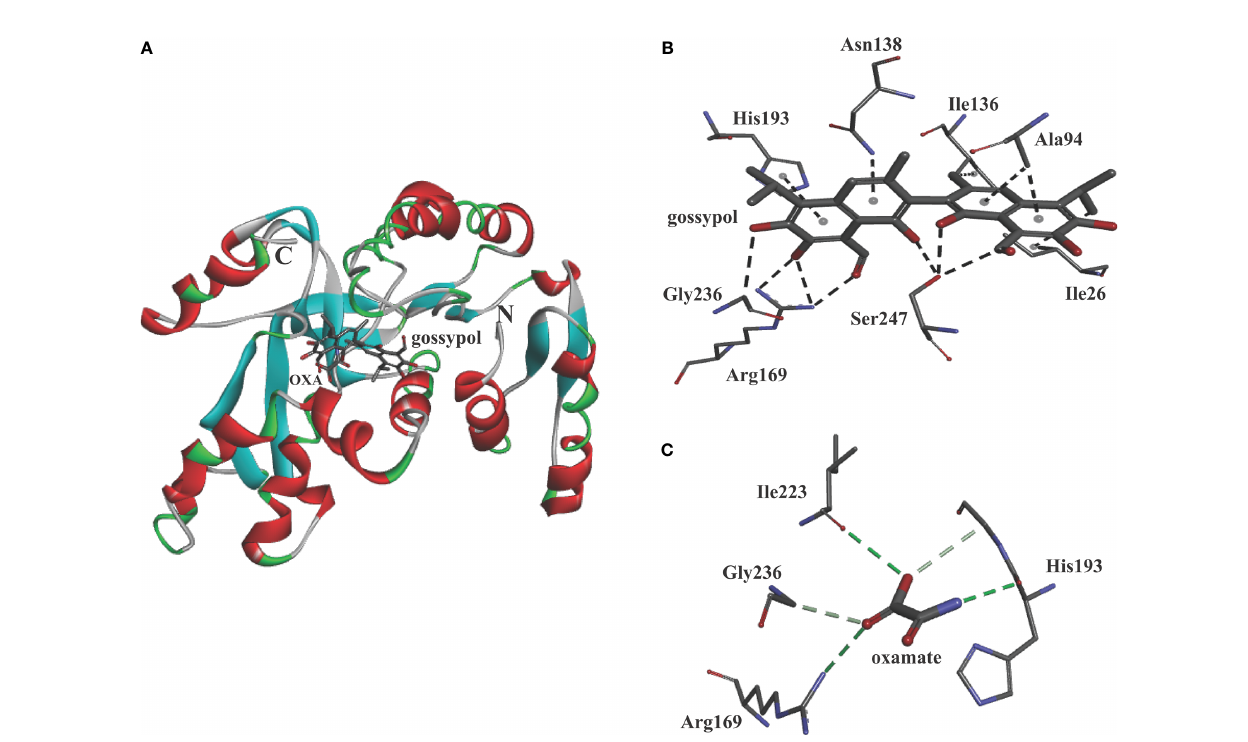
FIGURE 9 | Molecular model of gossypol with BoLDH. (A) Structural cartoon of BoLDH with gossypol on NADH binding pocket and oxamate on substrate binding pocket. gossypol and oxamate were displayed as stick diagram. (B) The distribution of hydrogen bonds and hydrophobic interactions at the gossypol interface. (C) The distribution of hydrogen bonds and hydrophobic interactions at the oxamate interface. The interacting amino acids in the binding network are labeled and shown as stick diagrams, and the dashed lines represent the hydrogen bonds and hydrophobic interaction between the respective donor and acceptor atoms. The two pictures were produced using Discovery Studio 2018 Client